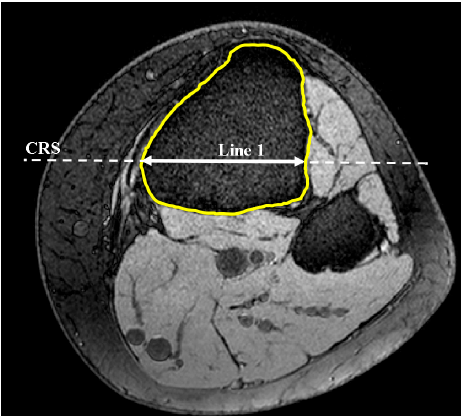
Figure 6. Identification of the longest medial-lateral line limited to tibial border in plane 1 and therein defining CRS (axial view).